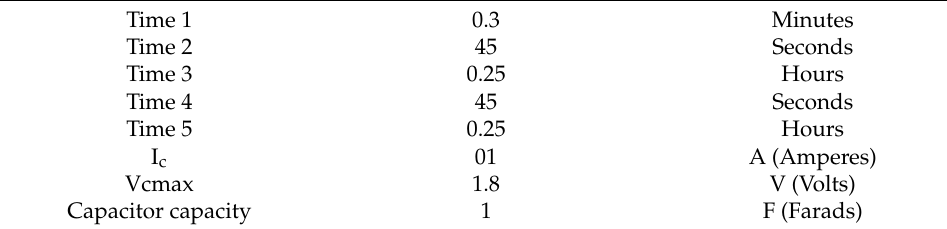
Table 3. Data initially programmed in the processing interface.